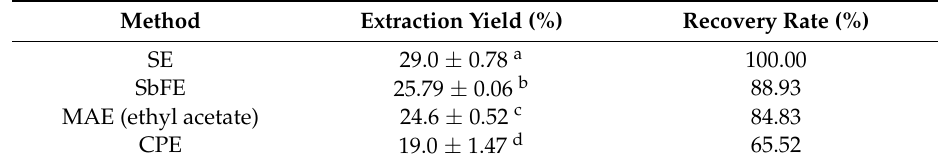
Table 3. The yield and recovery rate of C. sinensis seed oil extracted using the different